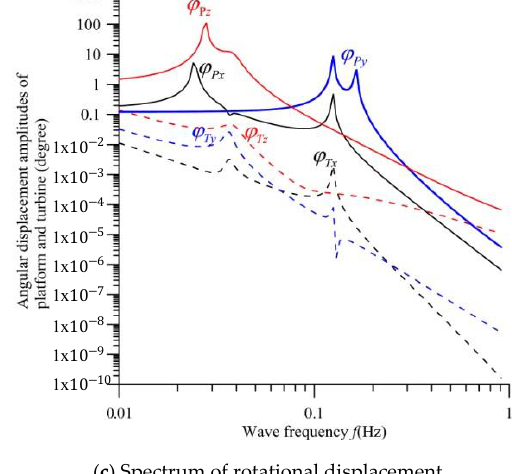
Figure 14. Spectrums of displacement and tension ( L C = 140 m, L D = 60 m P T 1 == ).